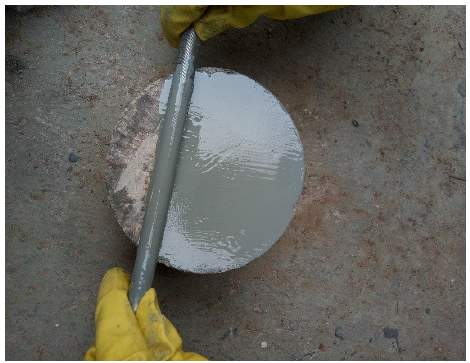
Figure 1. Application of paints on a concrete surface using a wire rod applicator.